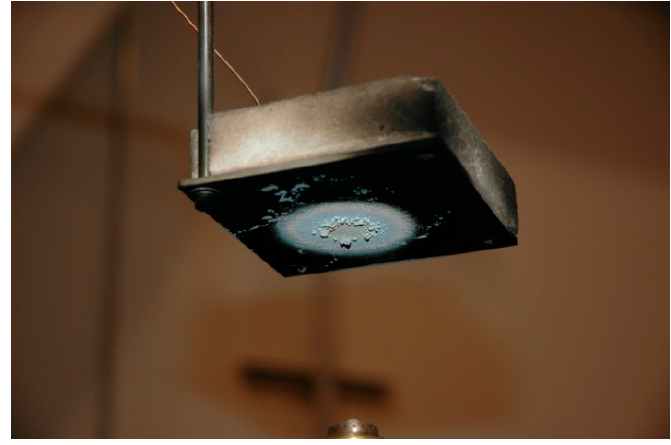
Figure 3. Post-test of the plate.